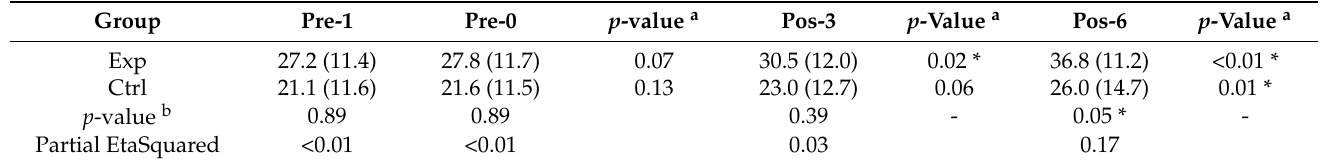
Table 3. Average FMA-UE scores in the study groups.